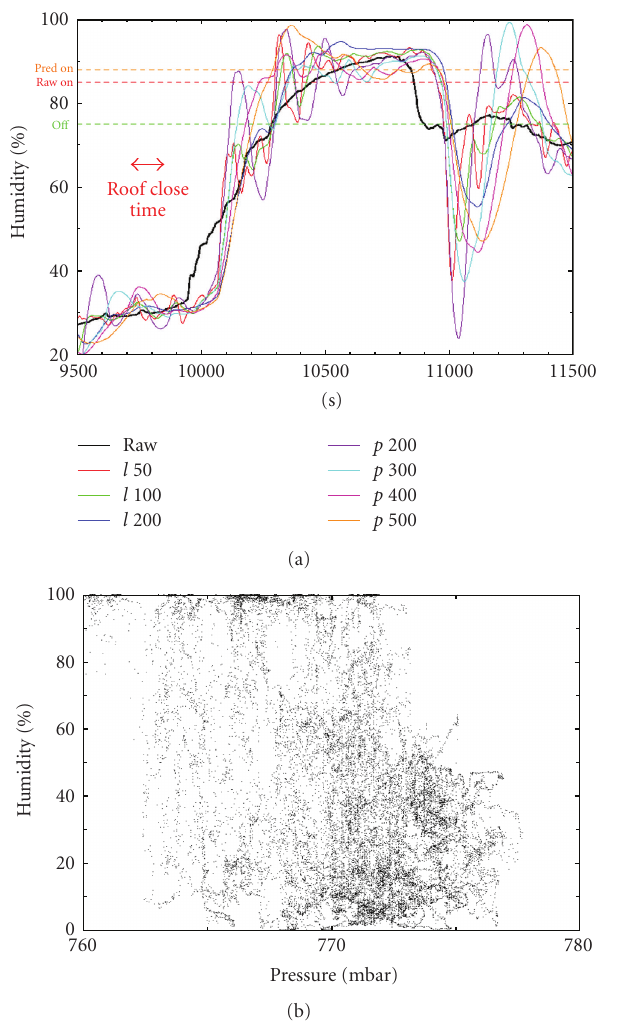
Figure 3: The SCS local cloud predictor. (a) The thick line represents measurements of a sudden humidity increase; that is, a cloud was moving across the STELLA weather stations. The x -axis is in seconds and the 2-minute slot needed to close the observatory roof is indicated. The predictor needs in about that time to predict the increase to the actual future value. For the incidence shown this was already the case when the humidity level was still low (50–60% in this case at t = 10100 seconds) and the roof closed well before the cloud could have been trapped inside the observatory bay. (b) The basis for that prediction is the (local) relation between humidity and barometric pressure. This relation is not strict but the likeliness of low humidity, that is, good weather, is high when the pressure is also high, that is, when the data fall within the lower right of above diagram.